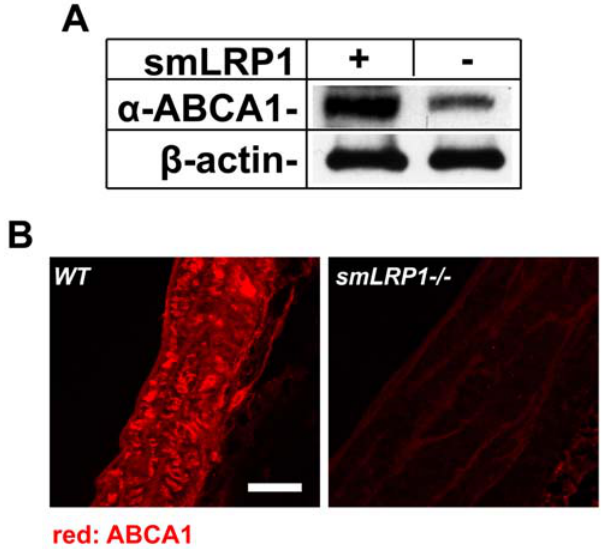
Figure 2. Detection of ABCA1 protein expression in the aorta by Western blotting and immunofluorescence microscopy. A . Aortas of the indicated genotypes were homogenized in lysis buffer. 10 m g of protein extracts were subjected to 4–15% SDS-PAGE gel, and the blot was then probed with a rat anti-mouse ABCA1 monoclonal antibody. b -actin was detected to demonstrate equal loading. Three independent experiments were quantitated. ABCA1 protein expression in smLRP- aortas was reduced to 0.39 6 0.04 compared to wild type. B . After fixation, aortas were embedded in paraffin and 5 m m sections were prepared. WT (left) and smLRP1 2 / 2 (right) aorta sections were then stained with the rat anti-mouse ABCA1 monoclonal antibody, and detected by Alexa-Fluor 568-conjugated goat anti-rat IgG (red). Images were acquired on a Leica TCS SP confocal microscope. Scale bar: 25 m m. Both assays showed greatly reduced ABCA1 protein expression in the aorta of the smLRP1 2 / 2 mice.